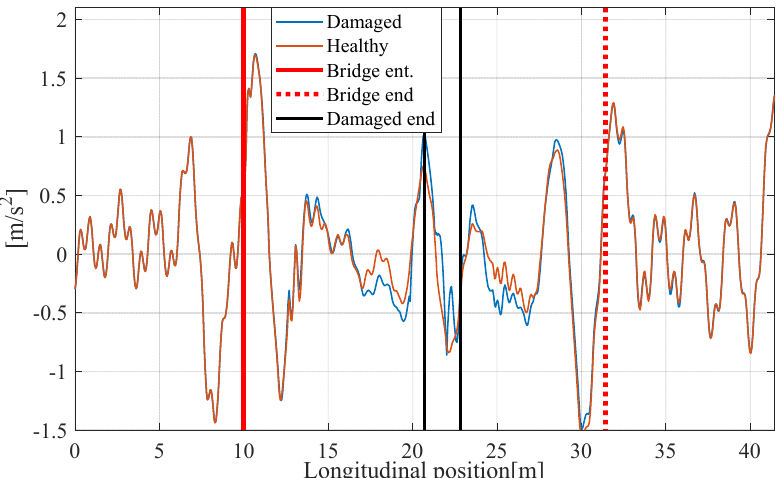
Figure 8. Damage detection results in the absence of track irregularity; the CSA train travels at 100 km/h and total damage on the fastening between the diagonal member and the lateral chord is considered ( a ) Module of the difference in wavelet coefficients. ( b ) Hilbert spectrum.